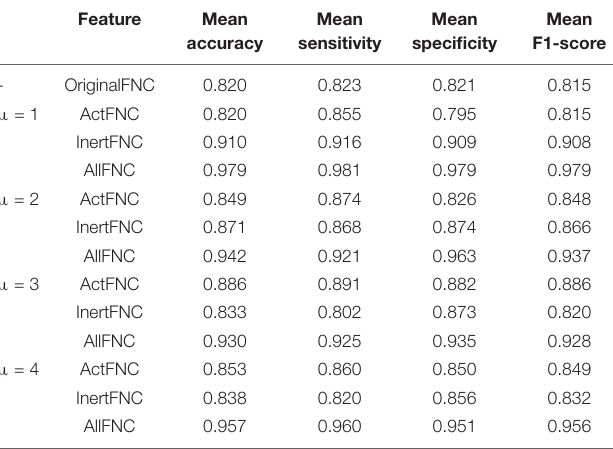
TABLE 4 | Classification performance of different features under different